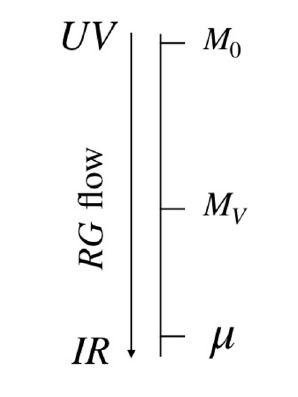
Figure 1. Three scales relevant for the RG (cid:13)ow of